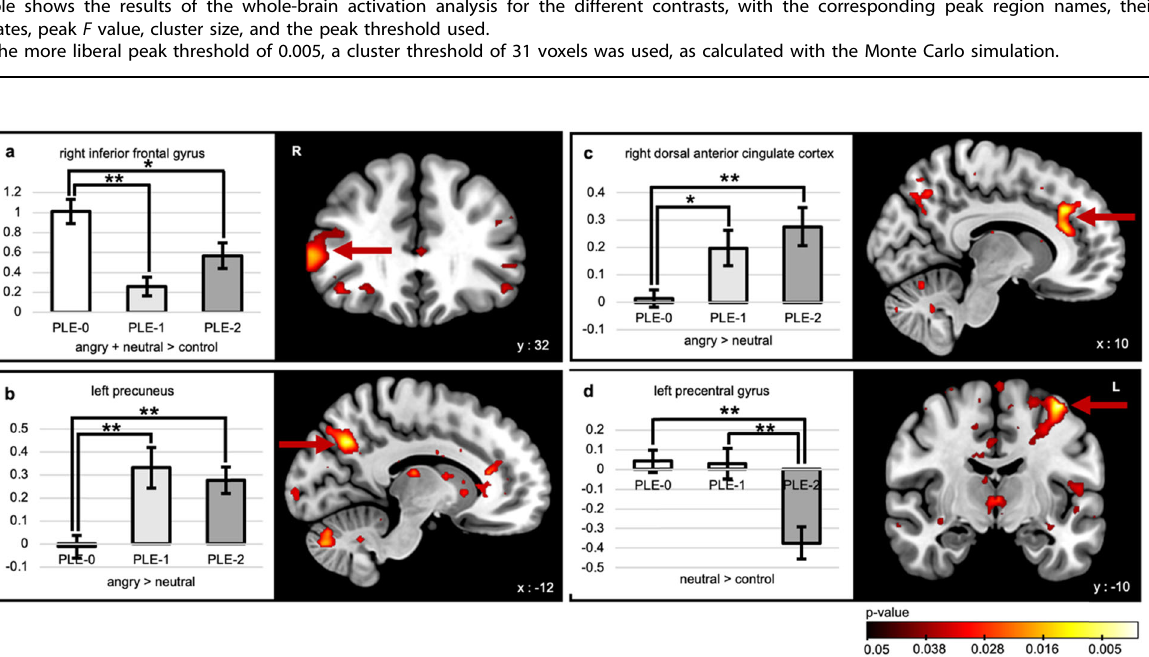
Fig. 1 Differences in brain activation during emotion processing in the PLE trajectories compared to typically developing adolescents. Between-group brain activation results for the different contrasts and bar graphs of the corresponding beta values for the three trajectories (PLE-0 = control trajectory; PLE-1 = decreasing trajectory; PLE-2 = increasing trajectory): a the right inferior frontal gyrus in the [(Angry + Neutral) – Control] facial cue processing contrast, b the left precuneus, and c the right dorsal anterior cingulate cortex in the (Angry − Neutral) negative emotion processing contrast, d the left precentral gyrus in the (Neutral − Control) neutral facial processing contrast. * p < 0.05, ** p < 0.005 (for display purposes, we used a peak threshold of p =